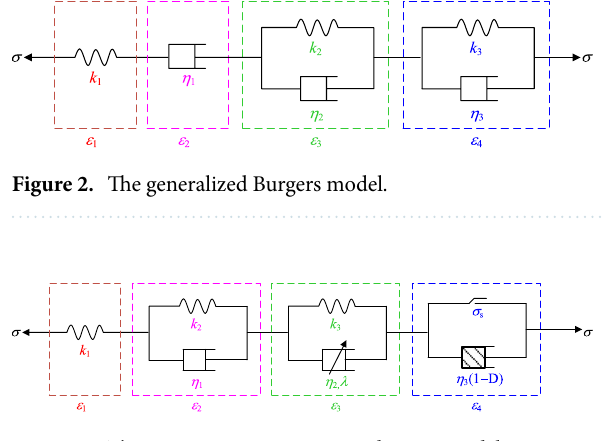
Figure 3. The varying-parameter creep damage